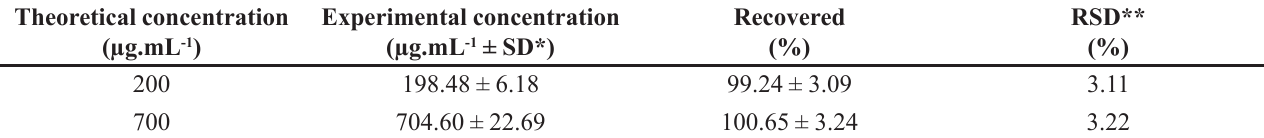
TABLE IV - Recovery assays for halcinonide analysis Theoretical